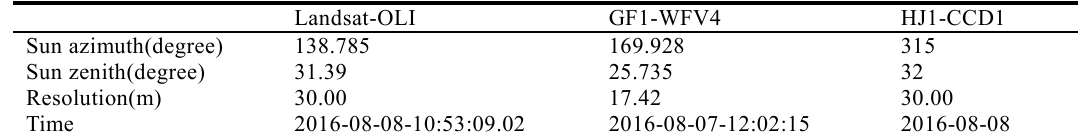
Table2.1. Comparison of basic parameters between Landsat8-OLI data and GF1-WFV4 and HJ1B-CCD2